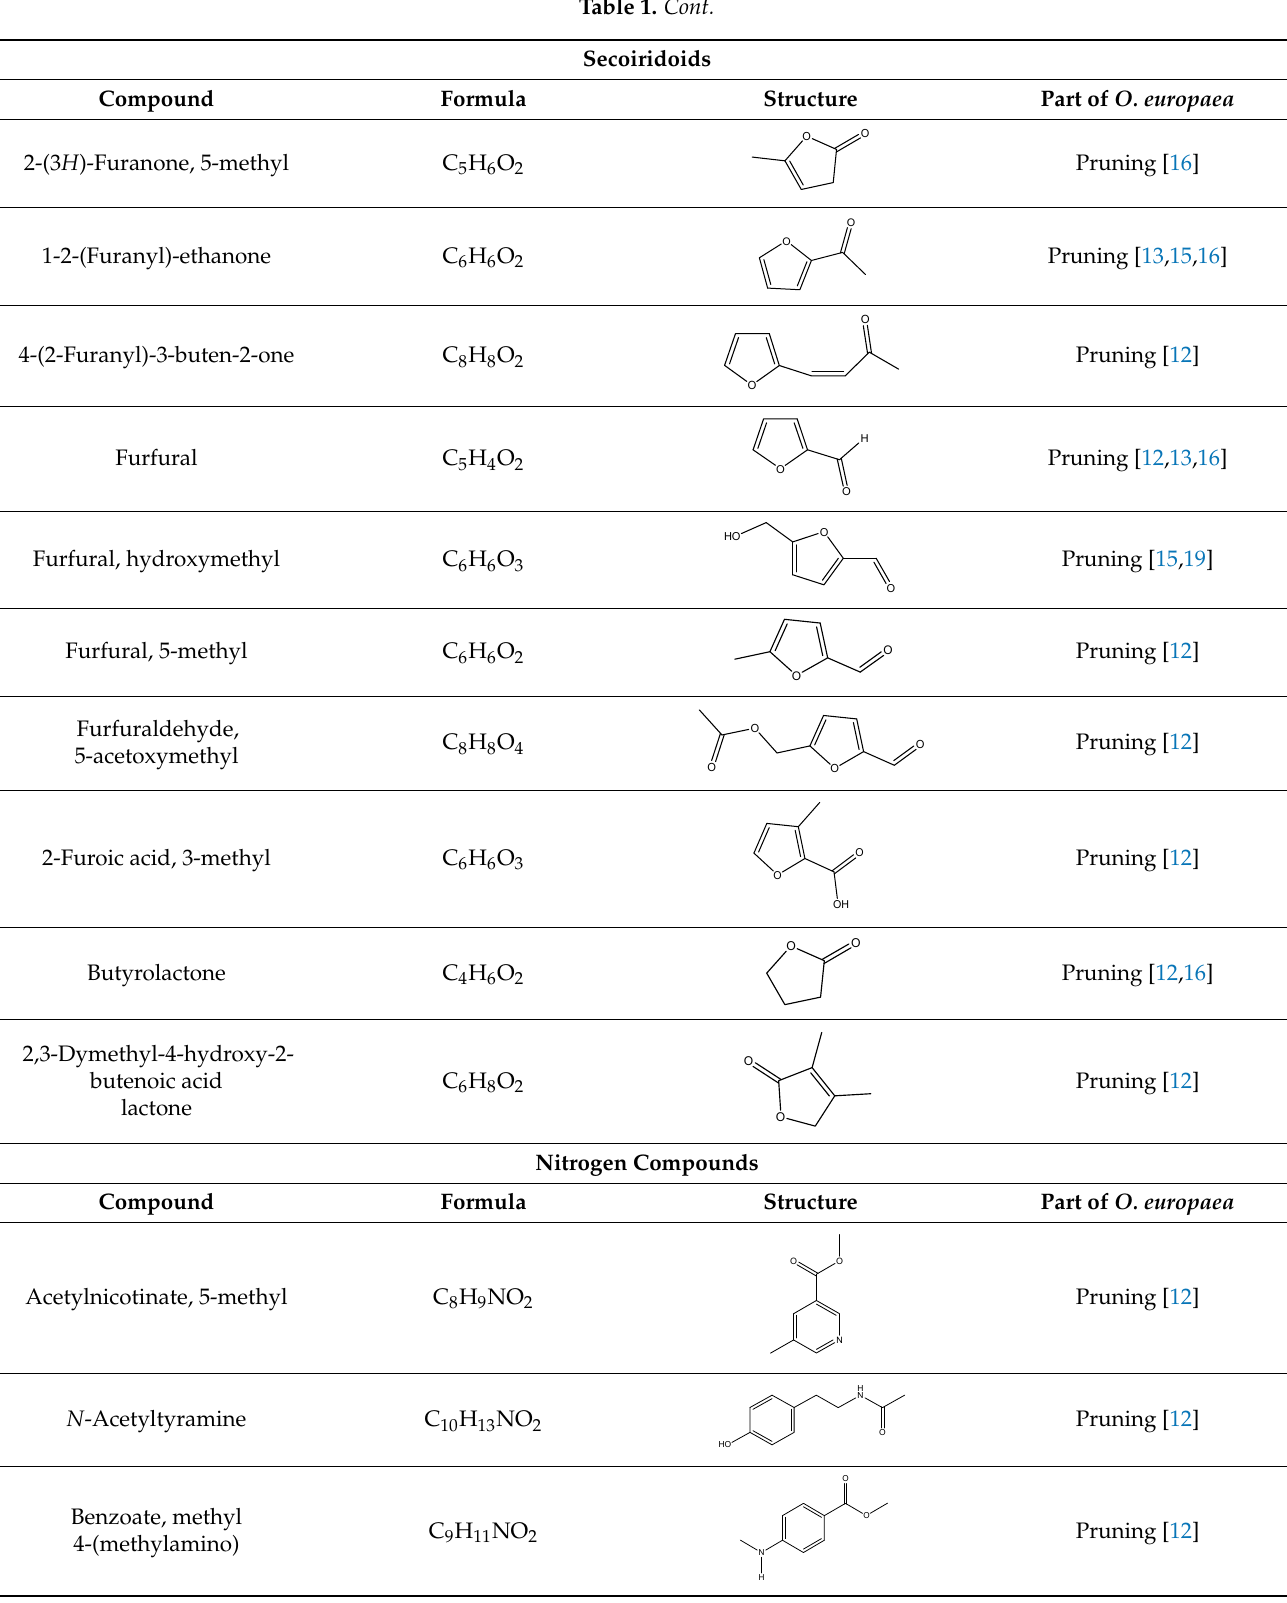
Table 1. Cont. Secoiridoids